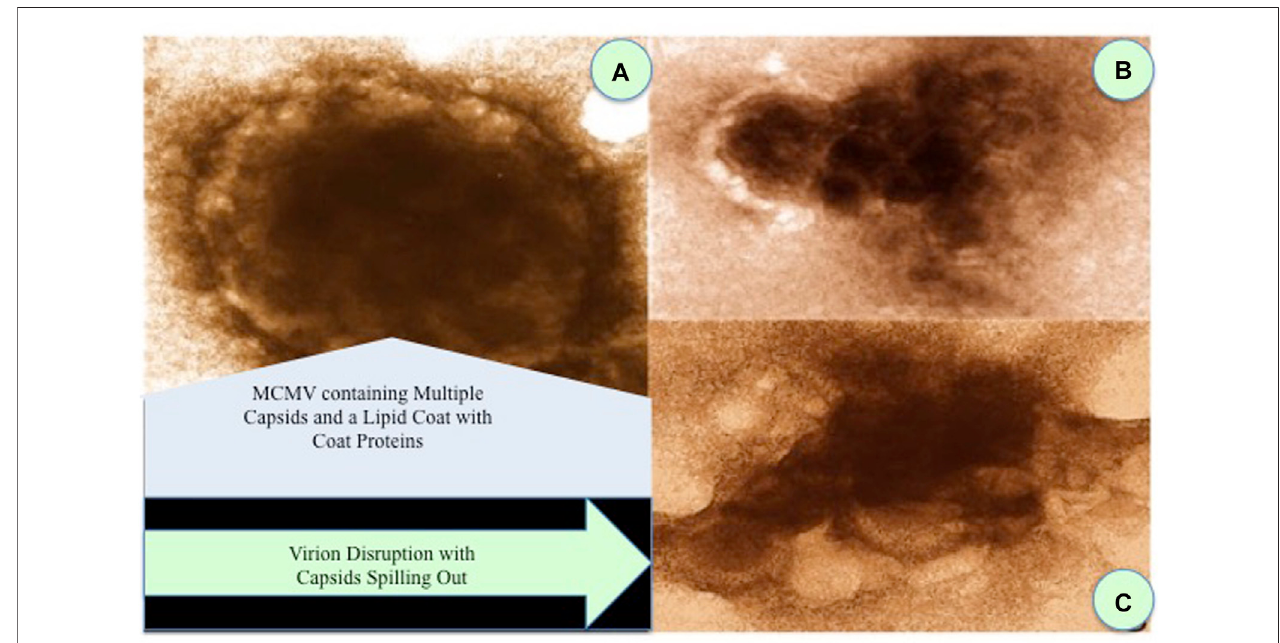
FIGURE 1 | Effects of two different nanoviricides binding to murine cytomegalovirus (MCMV). (A) Control treated virion: MCMV containing multiple capsids and a lipid coat with coat proteins. (B,C) MCMV virions treated with two different nanoviricides. Virion disruption with capsids spilling out.